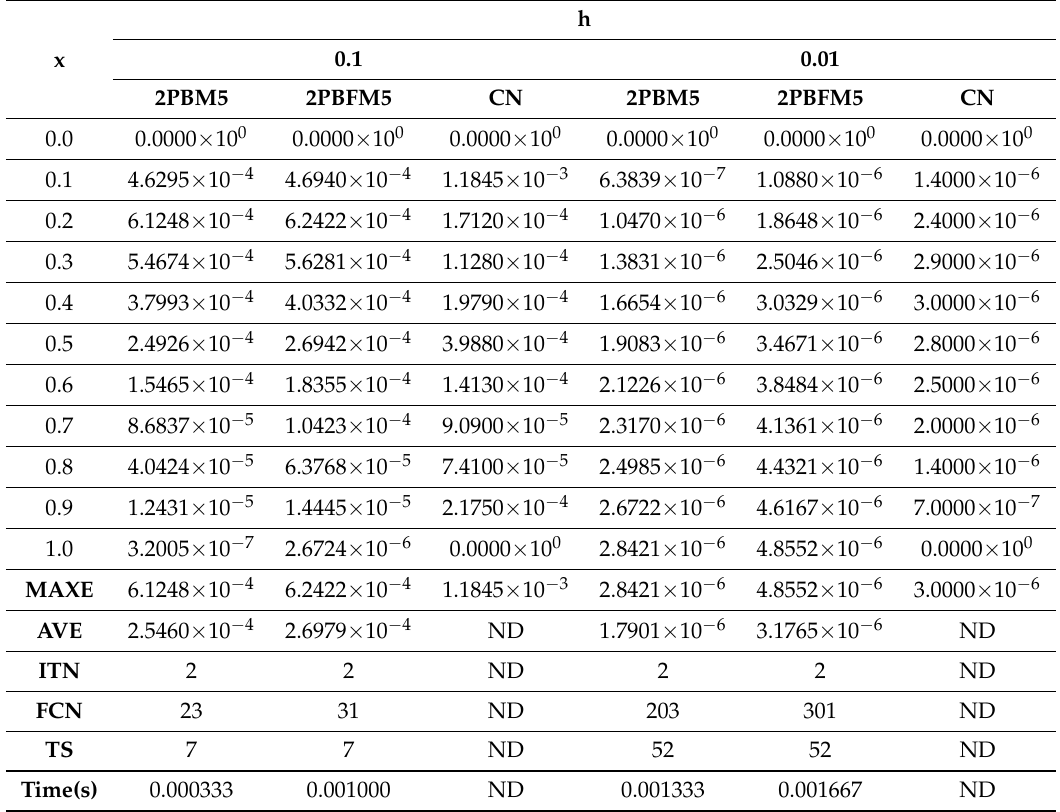
Table 8. The comparison results for Problem 4 at h = 0.1 and h =